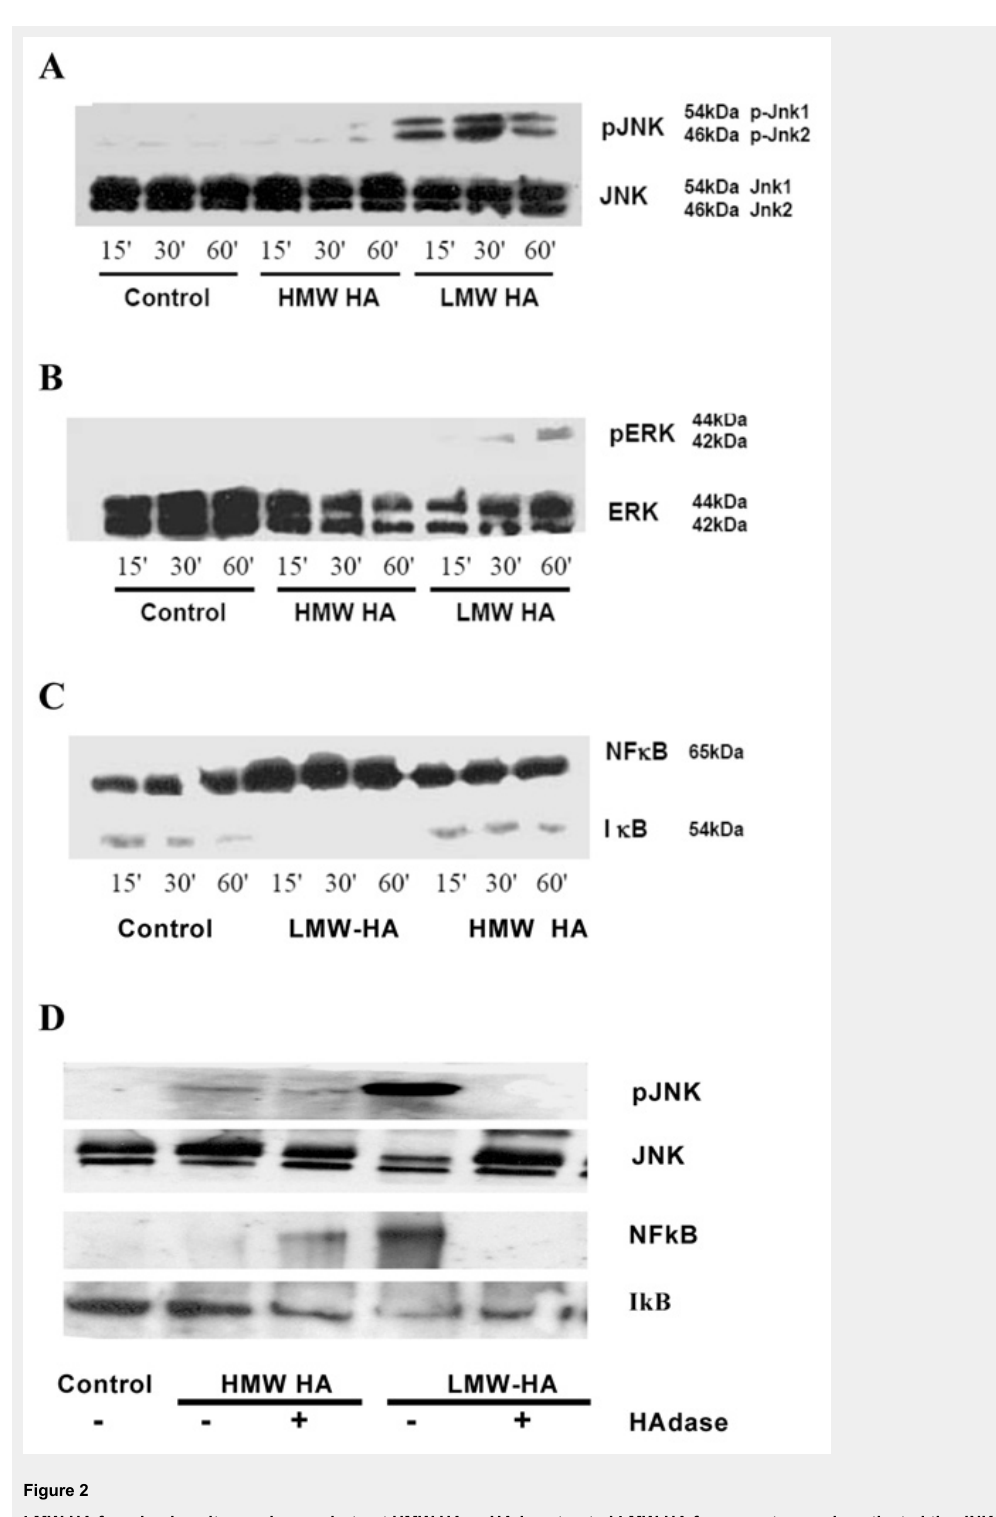
Figure 2 LMW-HA from bovine vitreous humor, but not HMW HA or HAdase treated LMW-HA from rooster comb, activated the JNK, ERK and NF-κB/IκB pathways in human BEAS-2B bronchial epithelial cells. Western blot analysis of effects of LMW-HA on BEAS-2B human transformed bronchial epithelial cells: A. c-Jun NH 2 -terminal kinase, B. ERK1 and ERK-2, and C. NF-κB in nuclear fraction / IκB in cytosol fraction, D. c-jun N-terminal kinase, NF-κB and IκB expression with HAdase treated HMW and LMW-HA. Each blot is representative of 3 separate experiments, and was quantified using densitometry. Results are expressed as fold-change compared with control in arbitrary units. * p <0.05 vs control. ‡ p <0.05 vs HMW